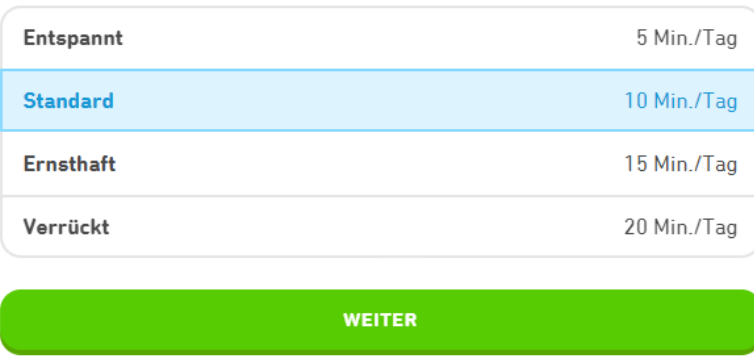
Figure 1: Selection offer for the daily workload in